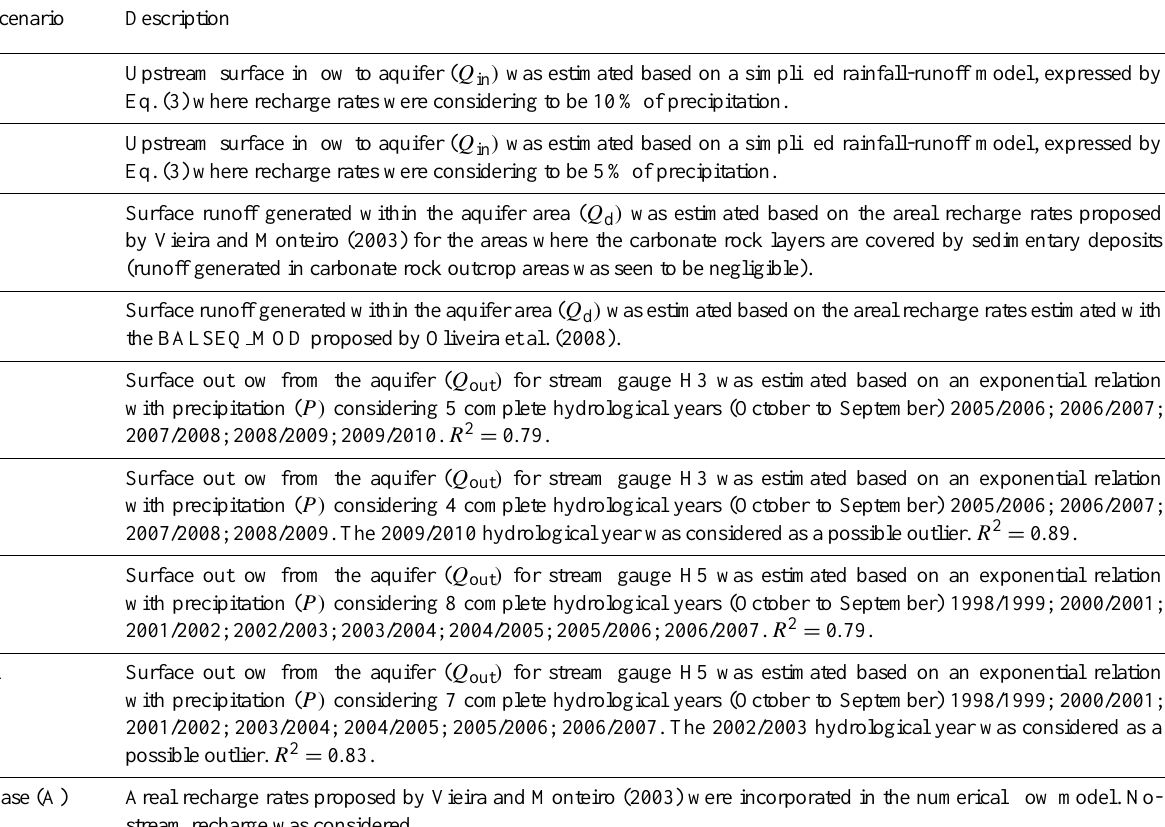
Table 1. Scenarios detailed